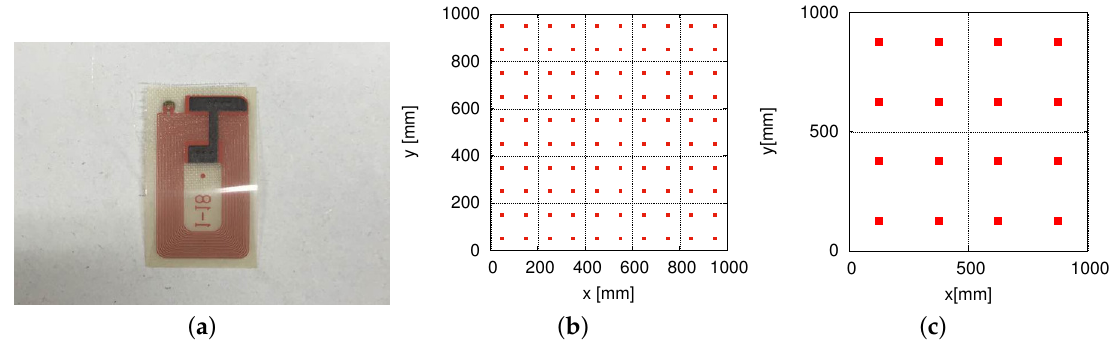
Figure 7. RFID tags in a lattice pattern. ( a ) Passive RFID tag; ( b ) 100 tags/m 2 ; ( c ) 16 tags/m 2